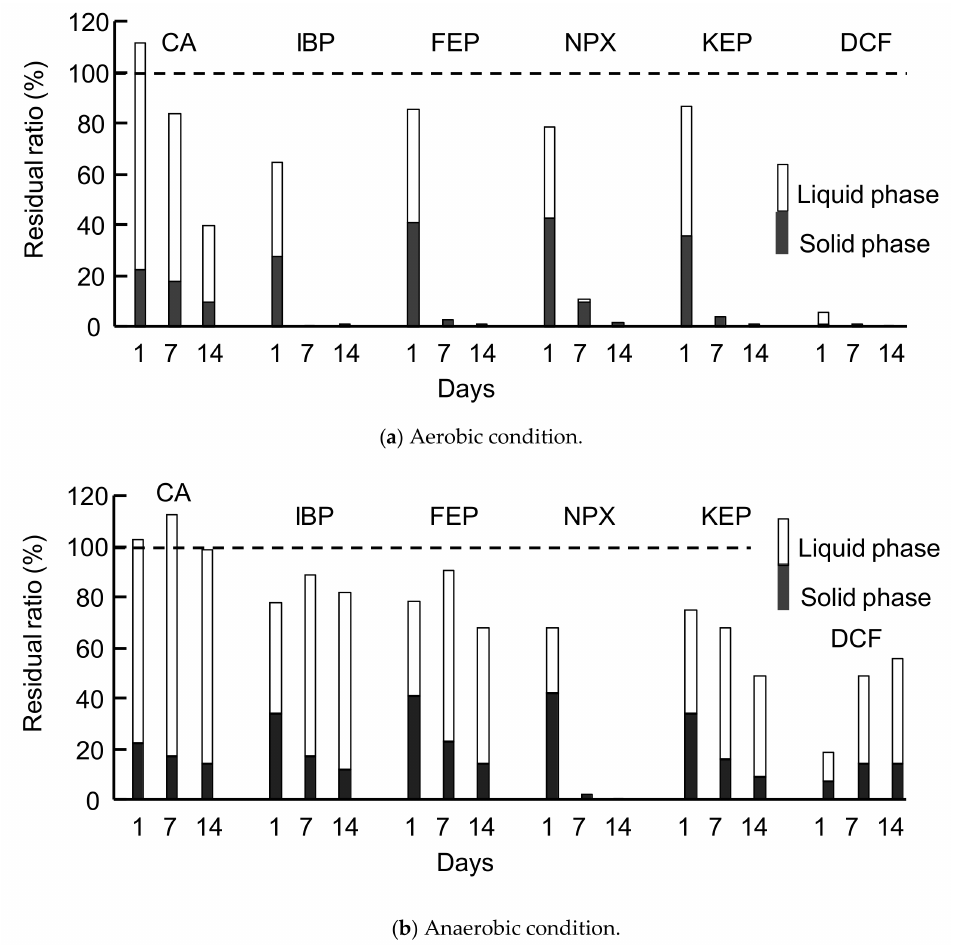
Figure 1. The residual ratios of pharmaceuticals as parent compounds with elapsed time by humic andosol (Ome) under ( a ) aerobic conditions and ( b ) anaerobic